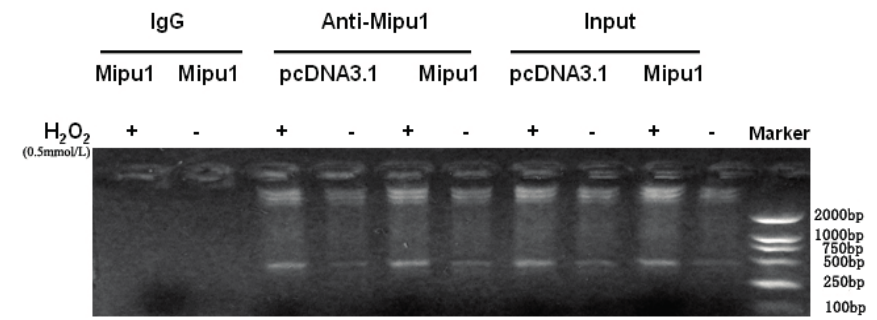
Figure 7. DNA binding activity of Mipu1 to Fas promoter shown by chromatin immunoprecipitation in H9c2 myogenic